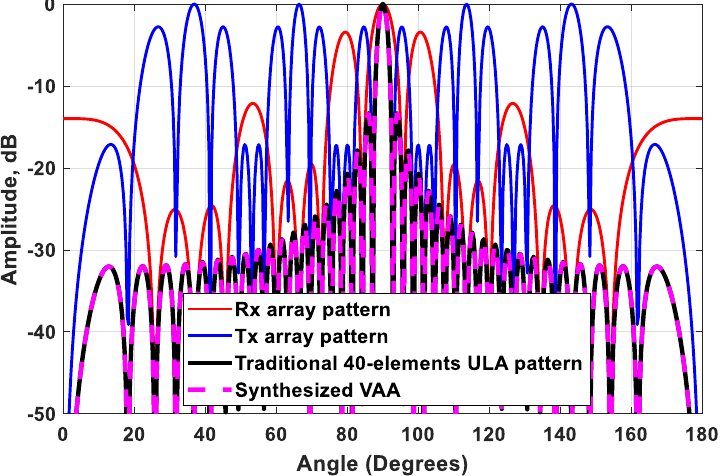
Figure 3. The synthesized N = 40-element VAA pattern for M = 5, Q = 2, P = 2, and d = λ /2 compared to the traditional 40-element ULA pattern.